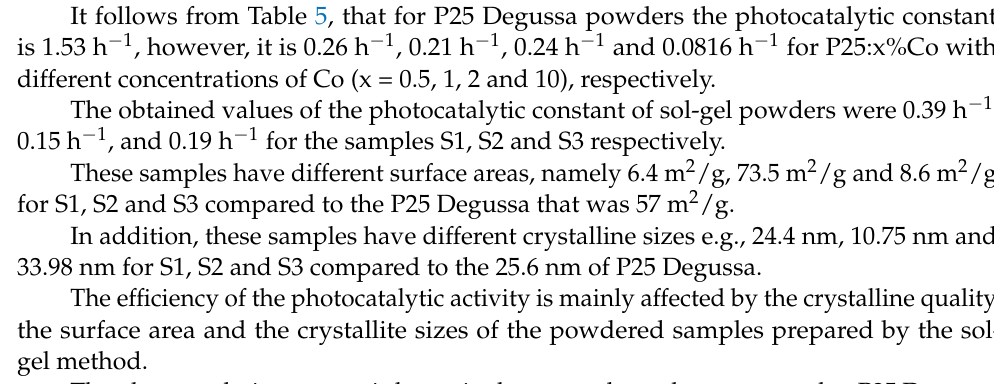
Figure 11. Spectrum of high-pressure mercury lamp and spectra of different spectral lines after the optical filters.